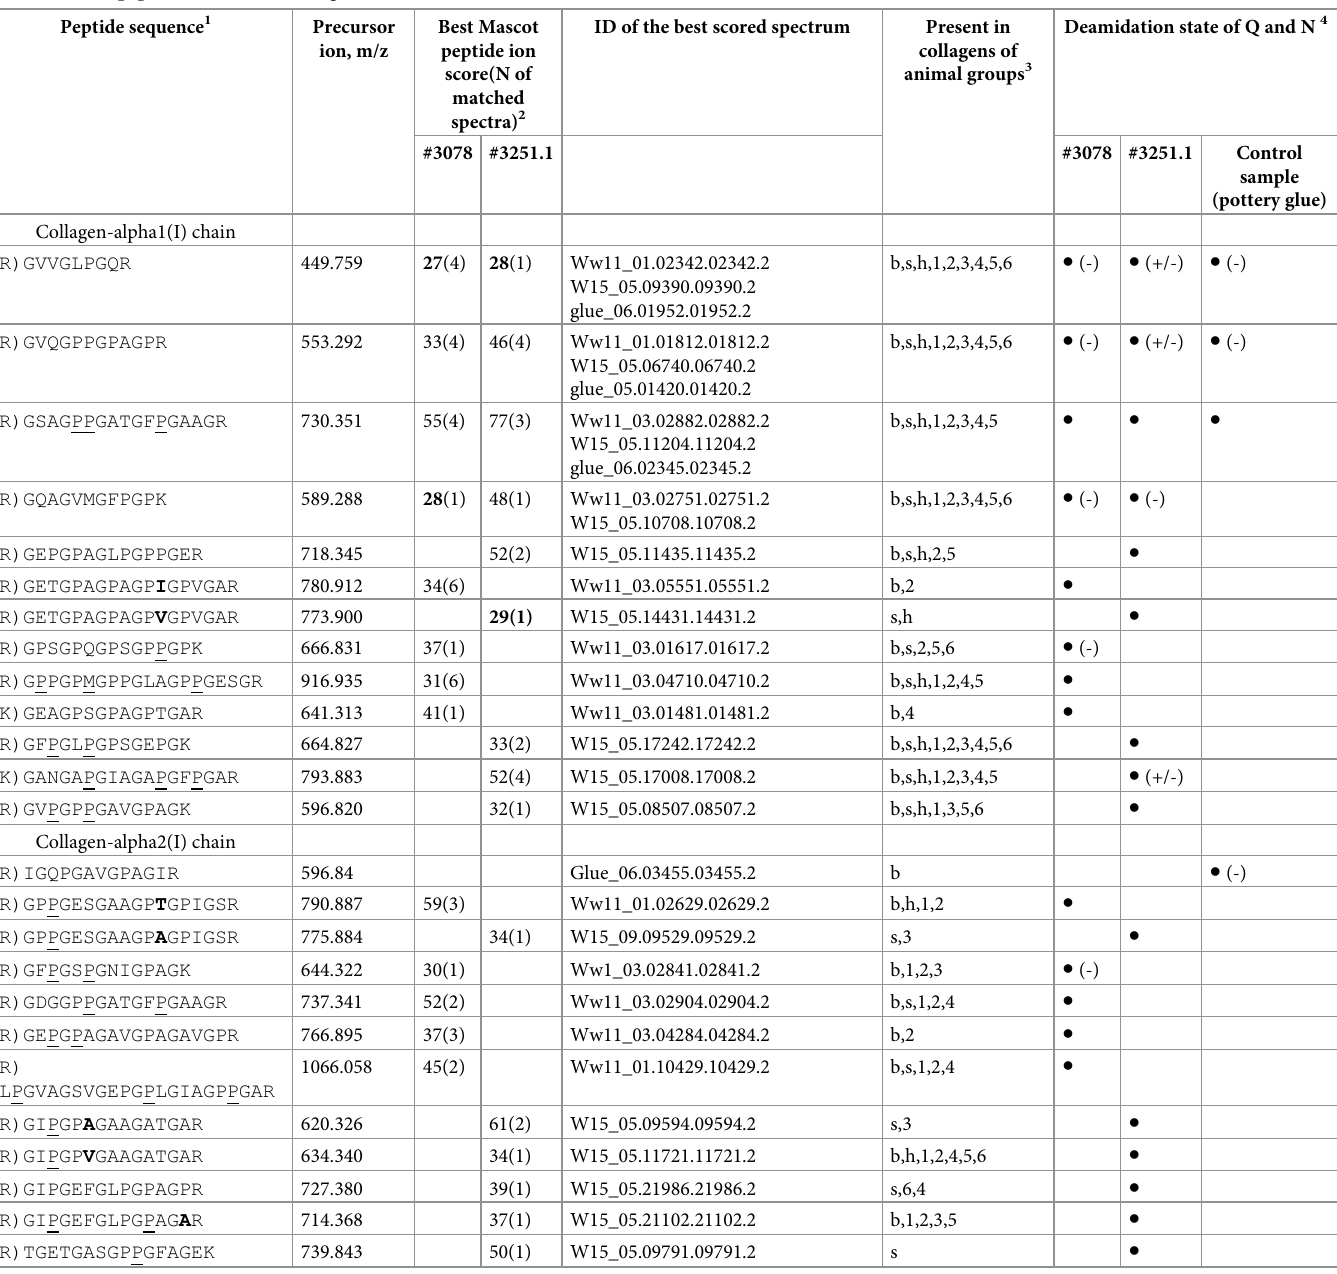
Table 3. List of peptides matched to collagens in foodcrusts #3078 and #3251.1. Peptide sequence